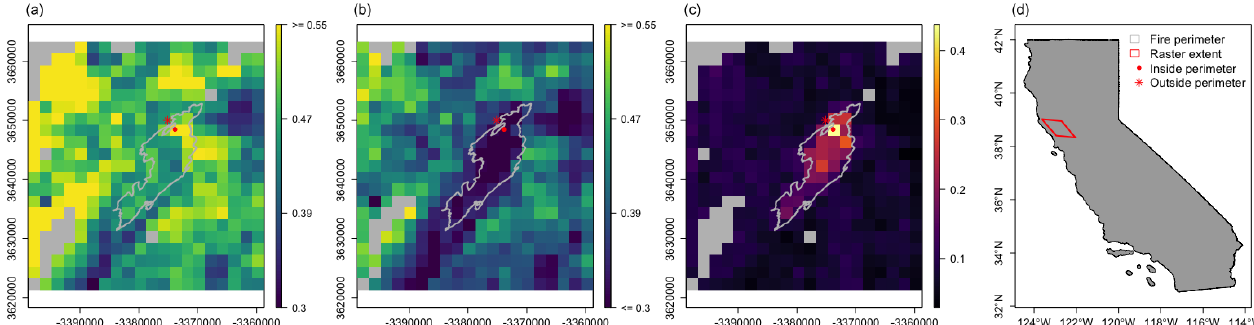
Figure 5. TOA NDVI calculated using the TOA reflectance factor from GOES-16 imagery for (a) day of the year (DOY) 295 (22 Oc- tober 2019) at 21:00UTC and (b) DOY 312 (8 November 2019) at 21:00UTC, and their difference (c) for the Kincade fire perimeter in northern California (d) (23 October 2019; DOY 296). Gray pixels were identified as being cloudy from the GOES Clear Sky Mask algo- rithm. The points inside and outside of the fire perimeter correspond to the time series in Figs. 3 and